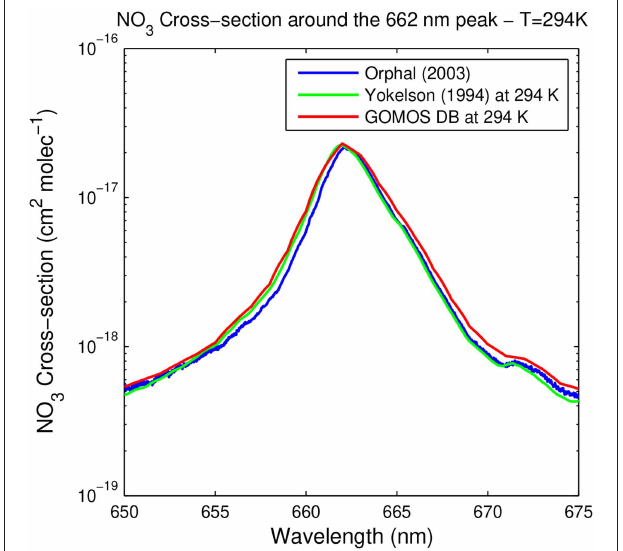
FIGURE 6 | NO 3 absorption cross-section around the peak at 662 nm, as provided by Orphal et al. (2003) (blue), the GOMOS cross-section database (red), and Yokelson et al. (1994) (green).